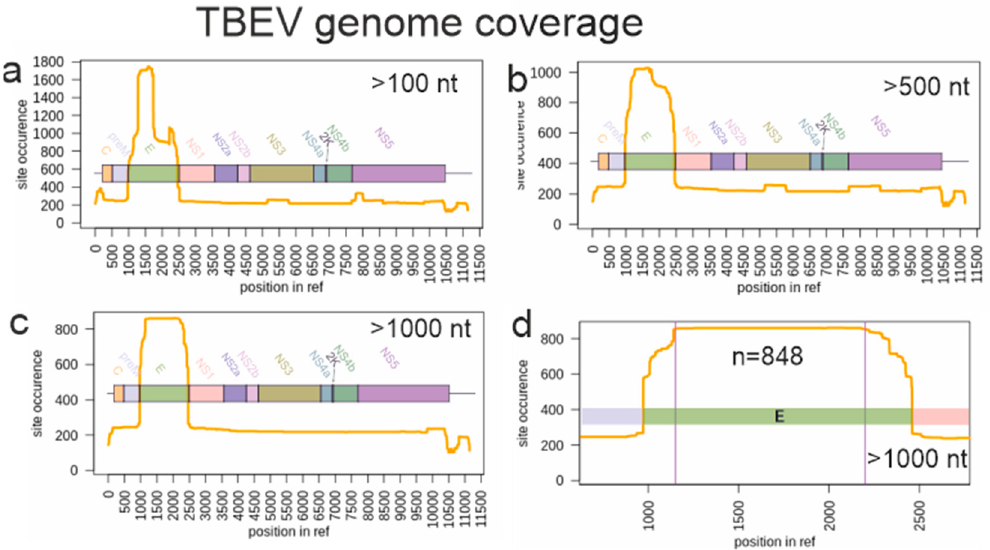
Figure 1. Genome layout and TBEV genome fragments represented in GenBank as of June 2019. Y-axis indicates the sequence coverage (the number of known sequences) for each genome position shown in X-axis. ( a ) Sequences shorter than 100 nucleotides were omitted from the analysis. ( b ) Sequences shorter than 500 nucleotides were omitted. ( c ) Sequences shorter than 1000 nucleotides were omitted. ( d ) The genomic region selected for the phylogenetic analysis is limited by two vertical lines.